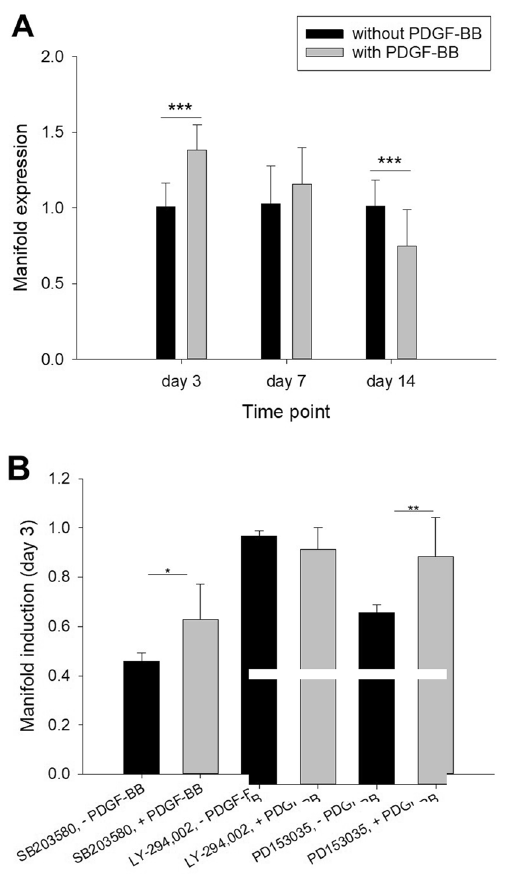
Figure 4. PAR-2 gene expression with 20 ng/mL PDGF-BB and without PDGF-BB after 3, 7 and 14 days under in vitro culture; manifold expression compared to cell culture without PDGF-BB; for tenocytes of four rabbits. ( A ). Manifold PAR-2 gene expression in a 3-day experiment, using different inhibitors in a 40 µM concentration and 5% FBS ( B ). Key: SB203580 = inhibitor for MAPK; LY-294002 = inhibitor for PI3K; PD153035 = inhibitor for EGFR (same family as PDGFR); DMSO = dimethyl sulfoxide (solvent of inhibitors); Medium = basal culture medium (with 10%